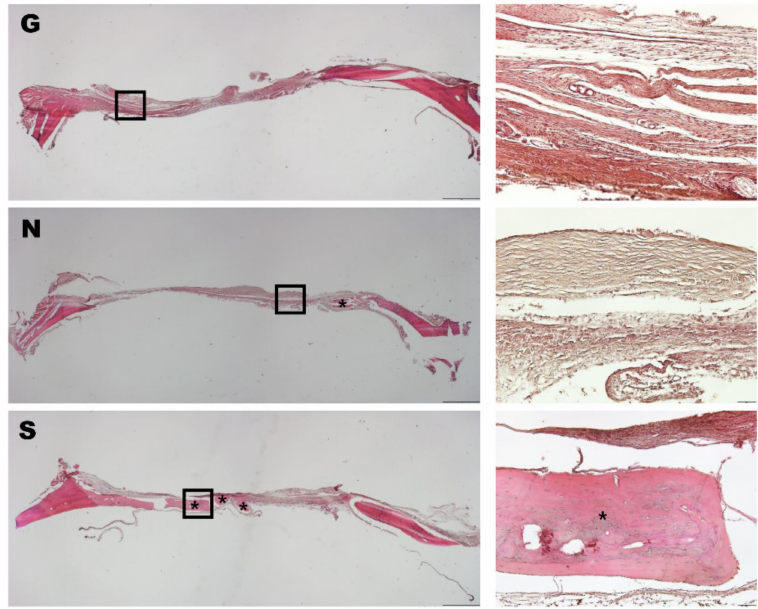
Figure 2. Images of histological analysis. Newly formed bone is represented by the islands marked with “*” located in the defect area (G: gelatin only group, N: unfilled control group, S: sericin combined with gelatin group). Figures in the right column are magnified images of the